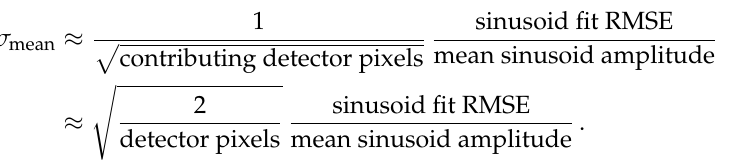
between 5 ( ∆ φ ( j ) − ∆ φ ( j ) − 2 π ) ). The variations ∆ φ ( j ) i i + 1 i 2 π 5